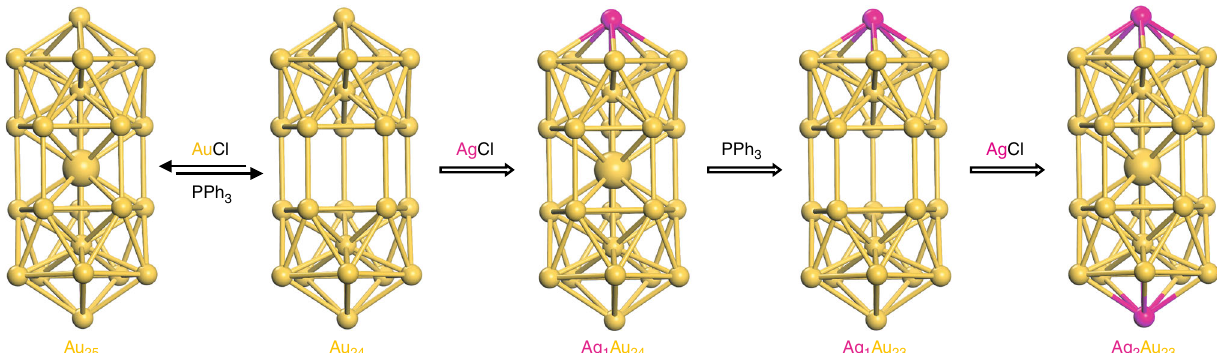
Fig. 7 Proposed mechanism of injecting two Ag atoms into the nanoparticle via the hollowing-re fi lling sequence: step 1, using PPh 3 to make a hole in the solid Au 25 nanocluster; step 2, using AgCl to re fi ll this hole and produce Ag 1 Au 24 ; step 3, continue using PPh 3 to make a hole in the Ag 1 Au 24 nanocluster and form the hollow Ag 1 Au 23 nanocluster; step 4, using AgCl to re fi ll the hole and yield the Ag 2 Au 23 nanocluster. Color code: Au, yellow; Ag,